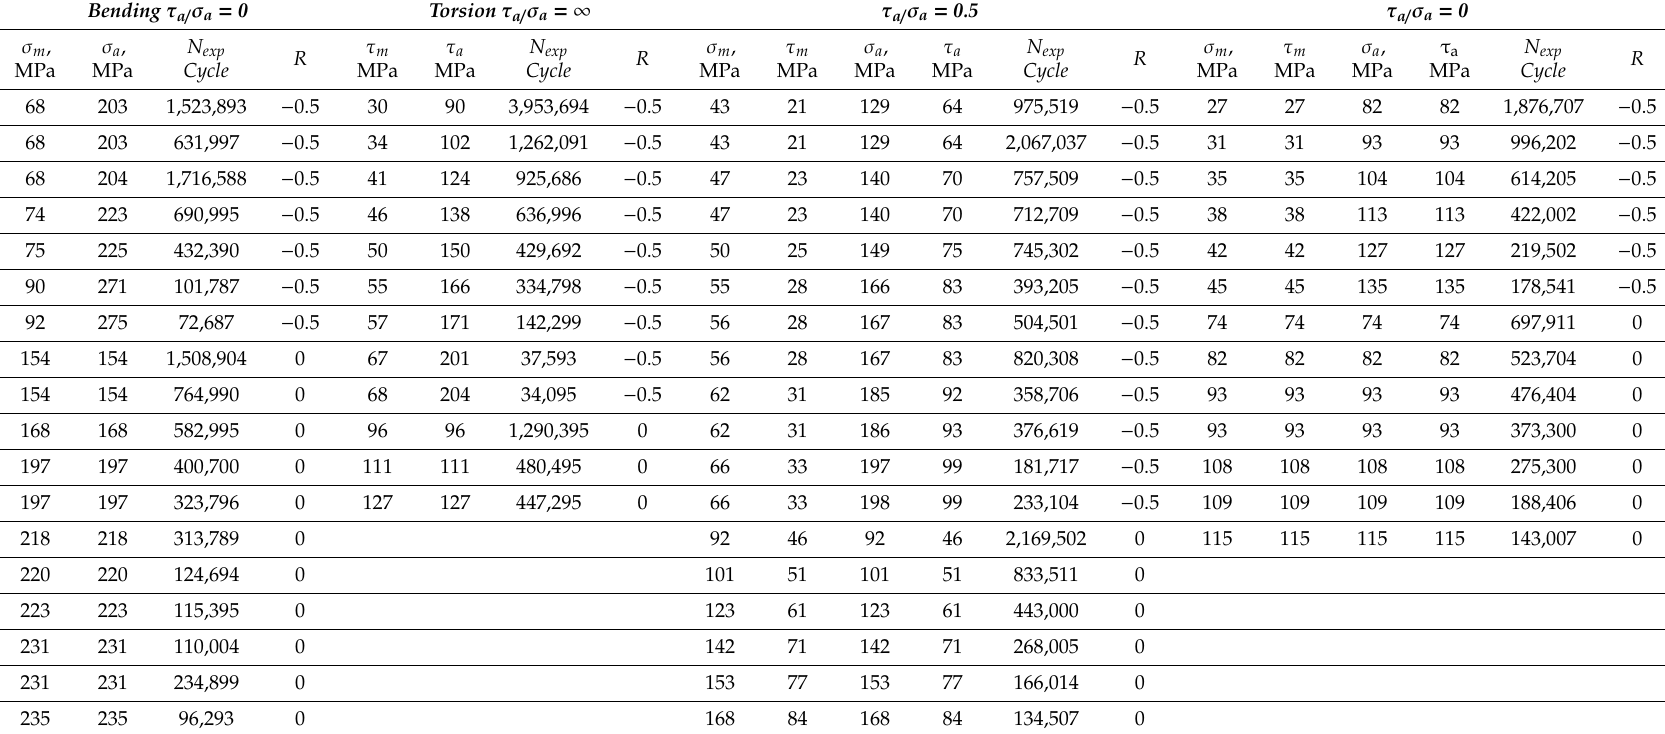
Table A1. Experimental results for the 7075-T651 aluminium alloy obtained under cyclic bending, torsion, and combined bending–torsion with di ff erent stress